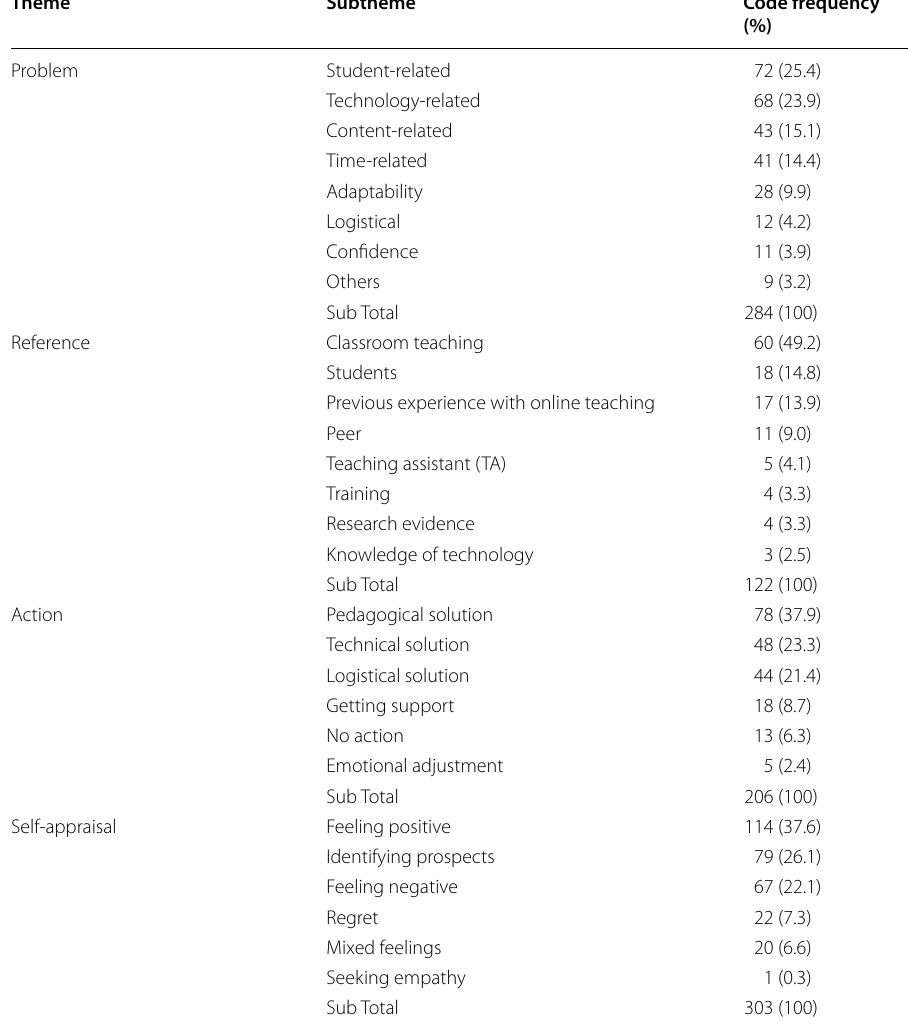
Table 3 Coding and categorization of faculty experiences during emergency online teaching